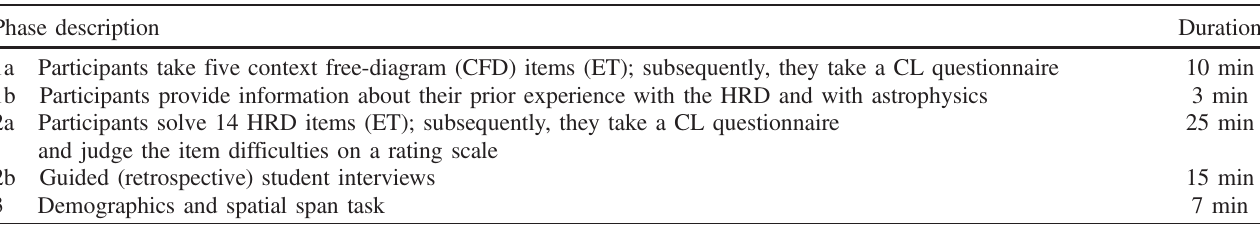
TABLE III. Elements of the experimental procedure [eye tracking (ET)].